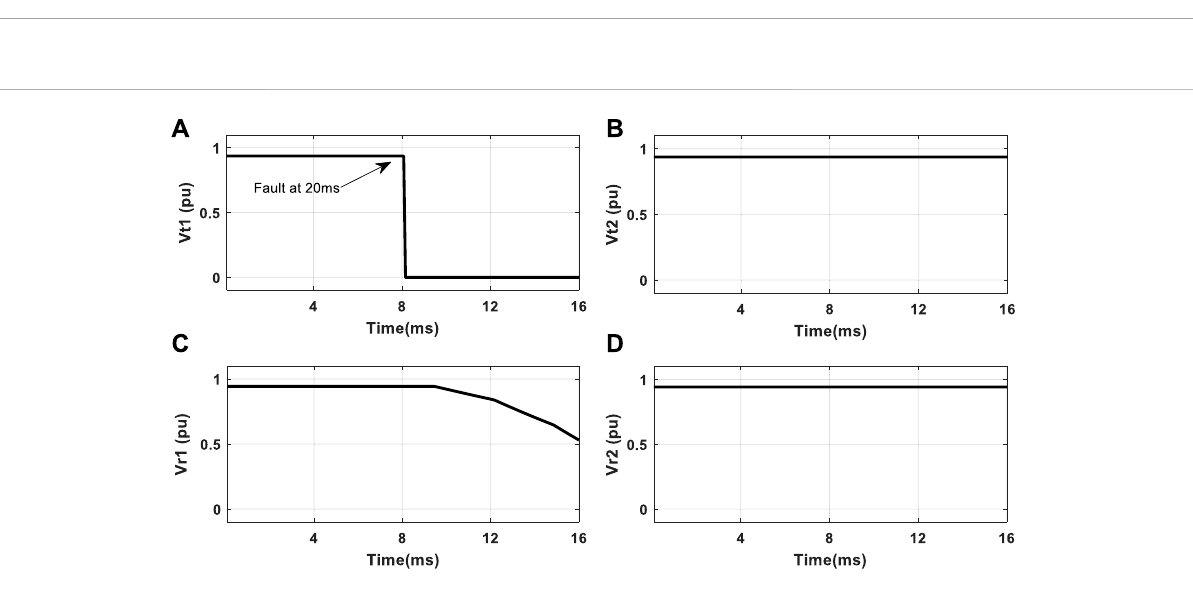
FIGURE 1 Bipolar LCC-HVDC transmission